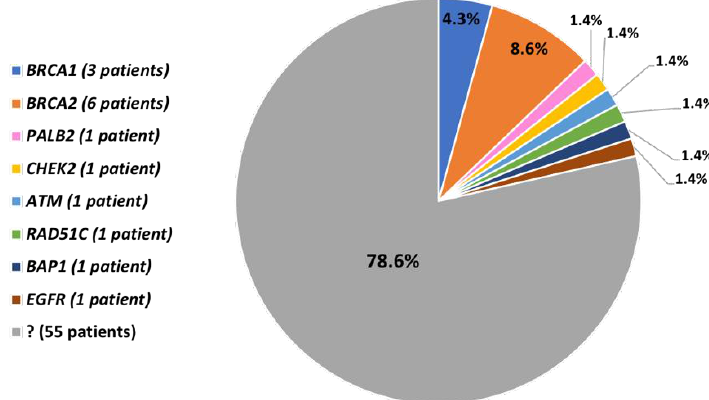
Figure 1. Pie chart showing the fraction of cases with/without PVs/LPVs; the number of variant carriers is reported between brackets.